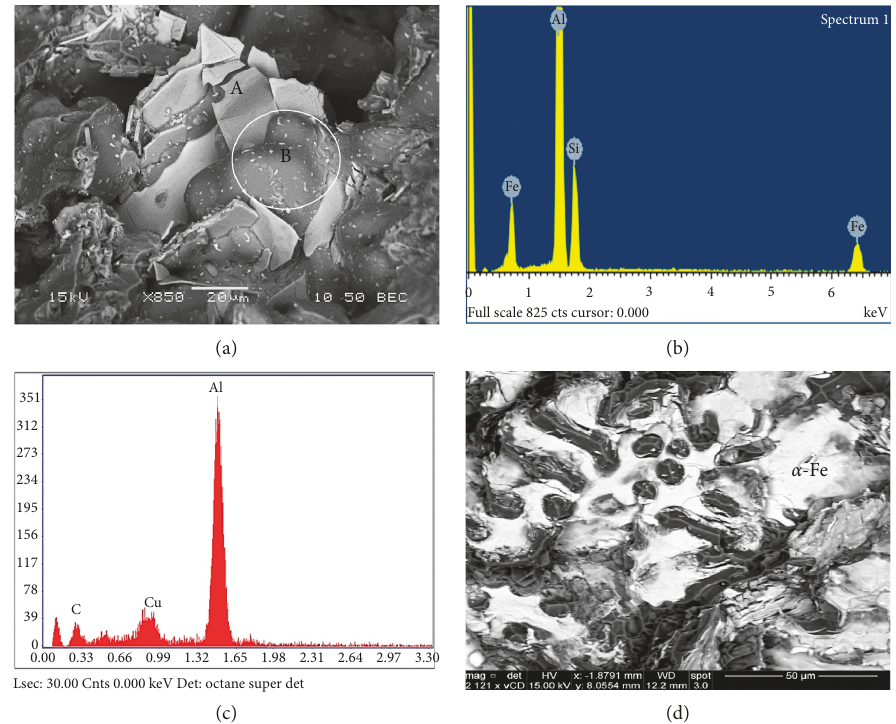
Figure 17: Backscattered electron micrographs of the fracture surface of alloys D and E following stabilization treated prior to testing at 250 ° C: (a) alloy D; (b) EDS spectrum corresponding to β -Fe platelets in (a) marked A; (c) EDS spectrum of Al 2 Cu particles in (a) marked B; (d) alloy